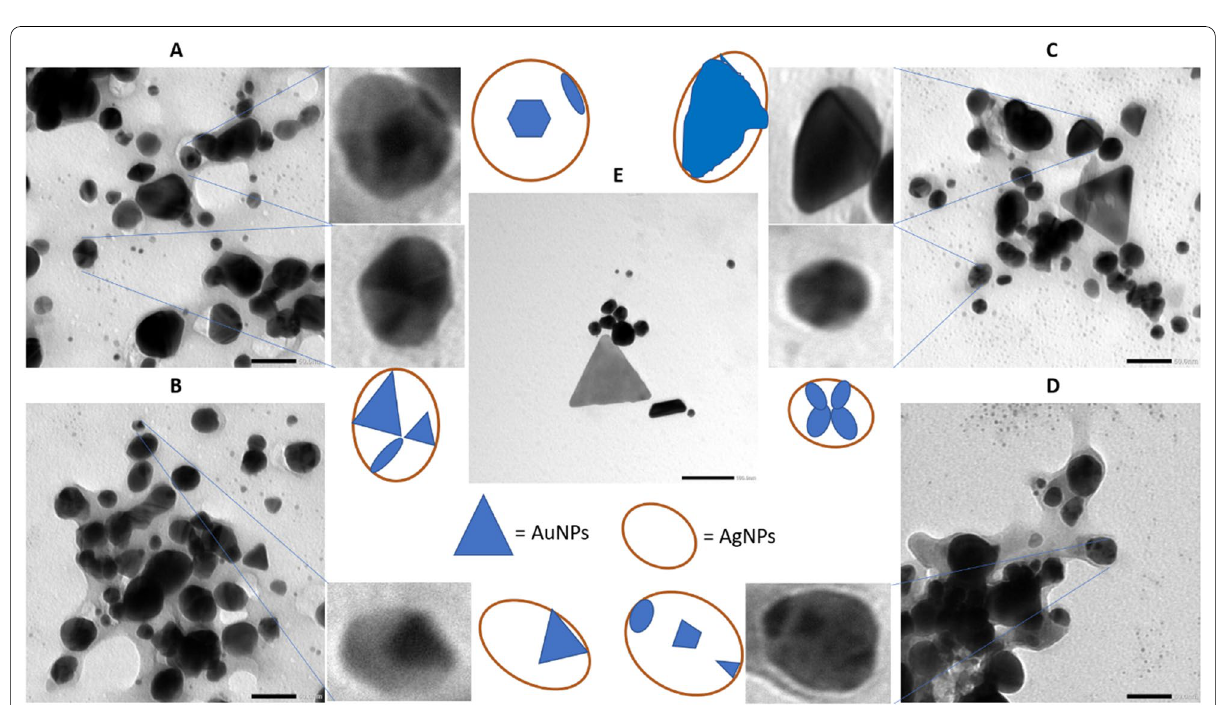
Fig. 4 The TEM images and suggested structures for A – D Au@AgNPs and different fields, with a scale bar of 50 nm, and E for AuNPs, with a scale bar of 100